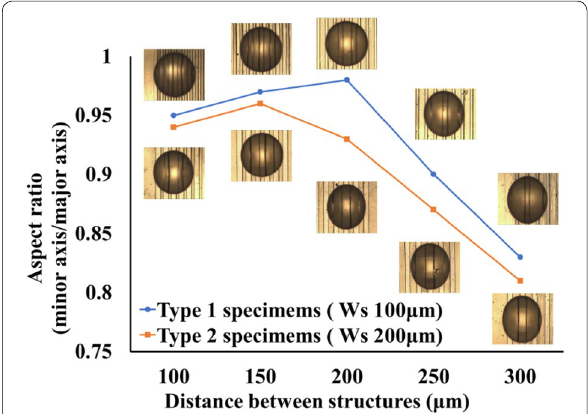
Fig. 7 Dependence of aspect ratio of water droplets on distance between the parallelogram